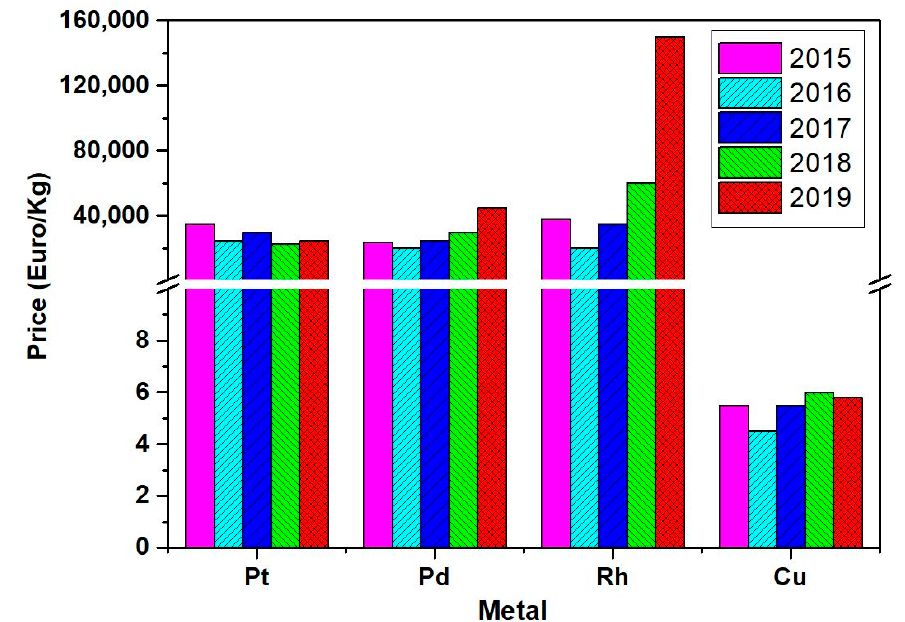
Figure 1. Relative comparison of noble metal and copper metal prices over the past five-year period. Data taken from https://www.infomine.com.